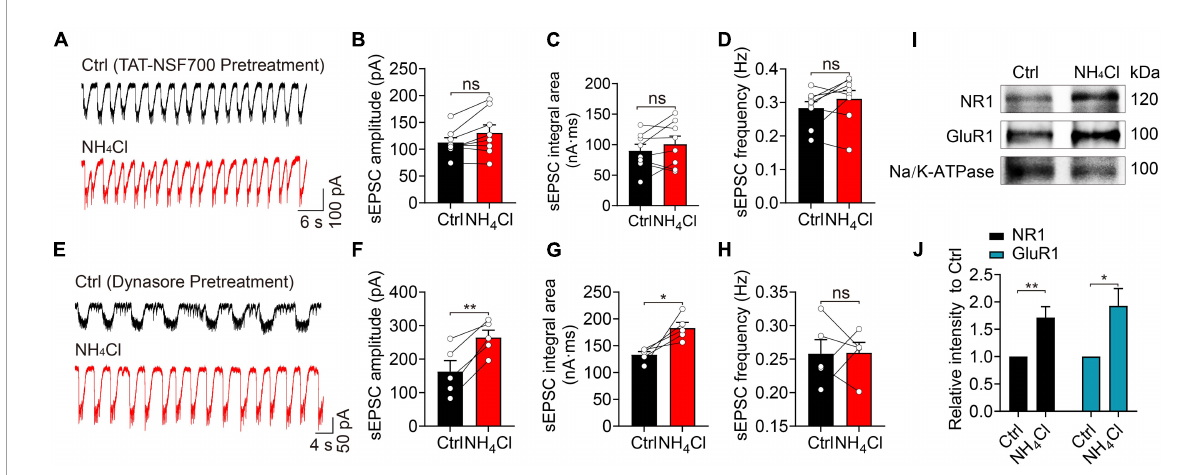
FIGURE6 Blocking of exocytosis with TAT-NSF700 or blocking dynamin-dependent endocytosis changes the effect of NH 4 + on the excitability of MCs. (A) Example traces of sEPSCs from a MC in the presence of Bic + Stry, showing that the sEPSC amplitude, integral area, and frequency were unchanged by NH 4 Cl after OB slices were pre-treated with TAT-NSF700 (5 µ M, 30 min), a permeable thrombin-induced exocytosis inhibitor. (B–D) Post hoc statistical analysis of sEPSC amplitude, integral area, and frequency in Ctrl and NH 4 Cl solution after OB slices